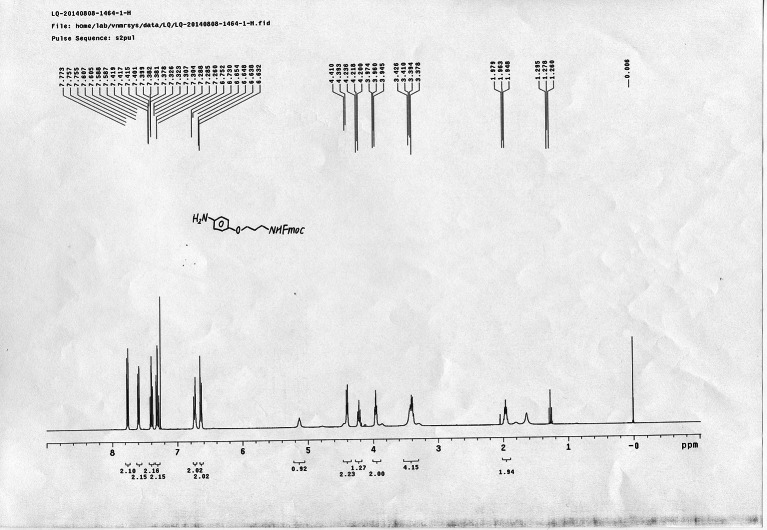
1H NMR spectra of compound 21.